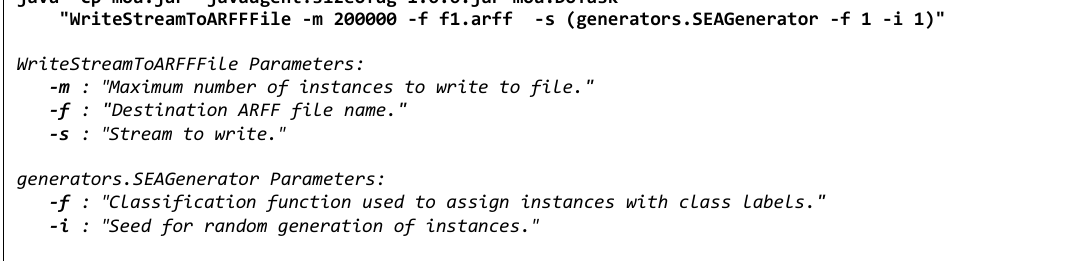
Figure 2. Command used to generate File 1 of streaming ensemble algorithm (SEA) dataset.